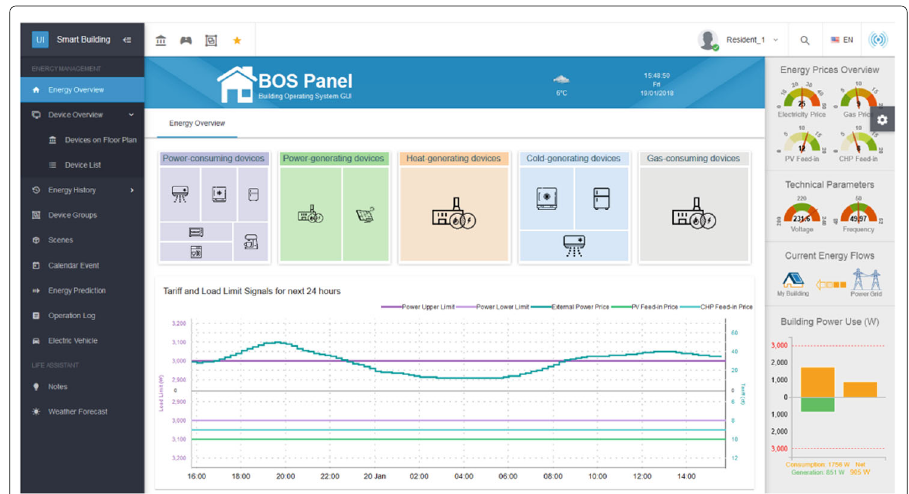
Fig. 14 BOS UI: real-time energy